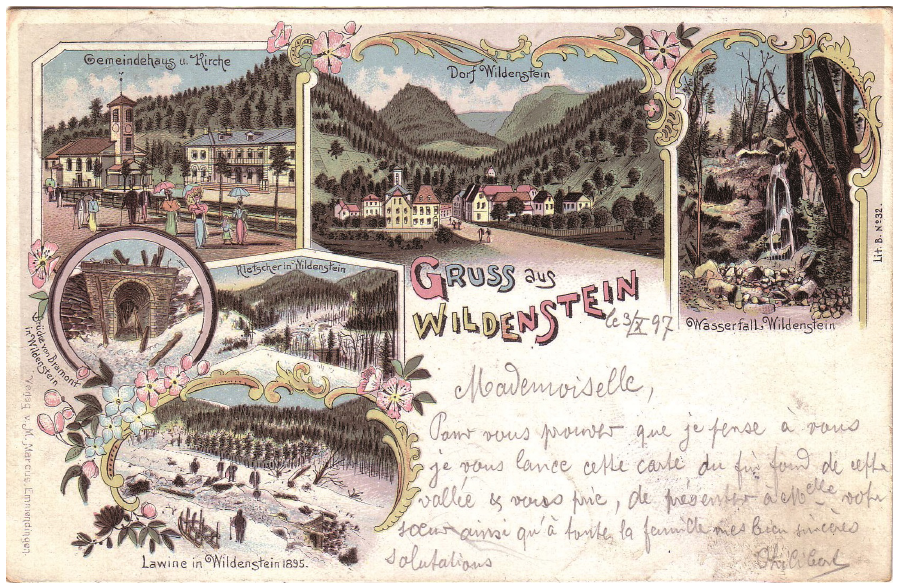
Figure 3. Postcard of Wildenstein (township in the Vosges Mountains) that shows (bottom left) an avalanche that occurred in February 1895, Lawine meaning avalanche in German (Alsace was part of the second Reich at that time). The postcard was circulated in 1897. Private collection: J.-M. Ernst, consultation through T. Meyer.